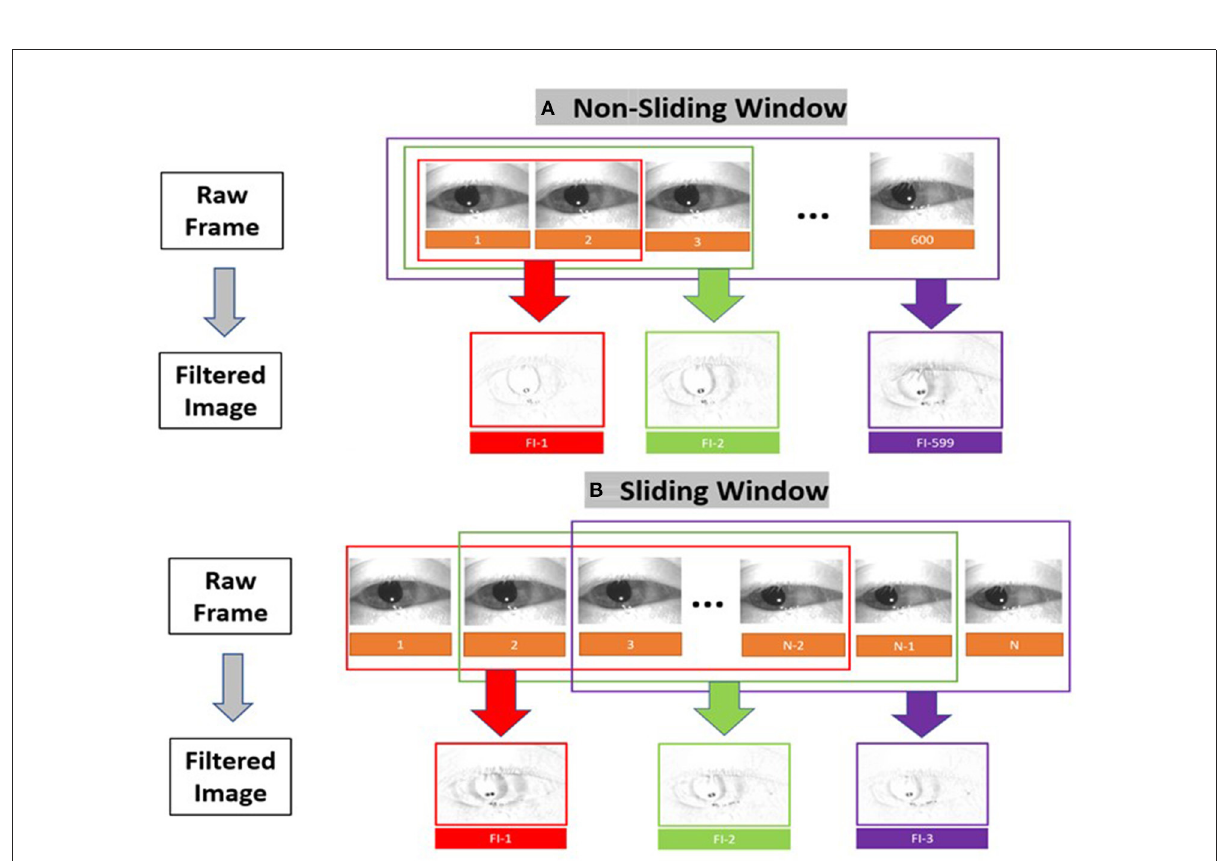
FIGURE4 Filtered image construction for (A) the non-sliding window and (B) the sliding window variations.